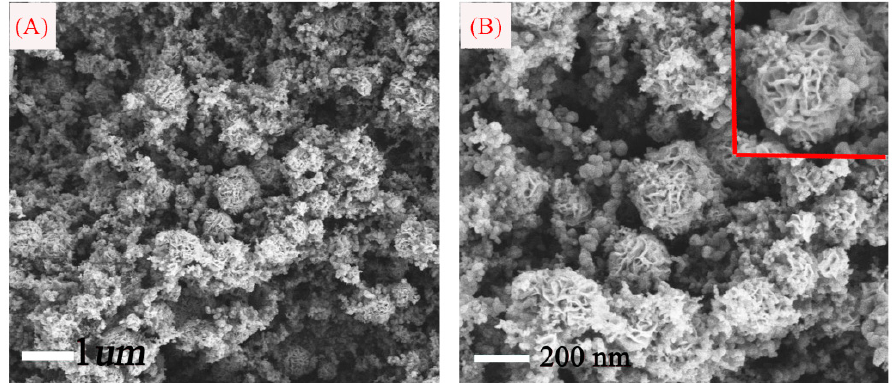
Figure 2. SEM images of MoS 2 /C nanocomposites at different magnification: 1000 magnification ( A ) and 20,000 magnification ( B ).